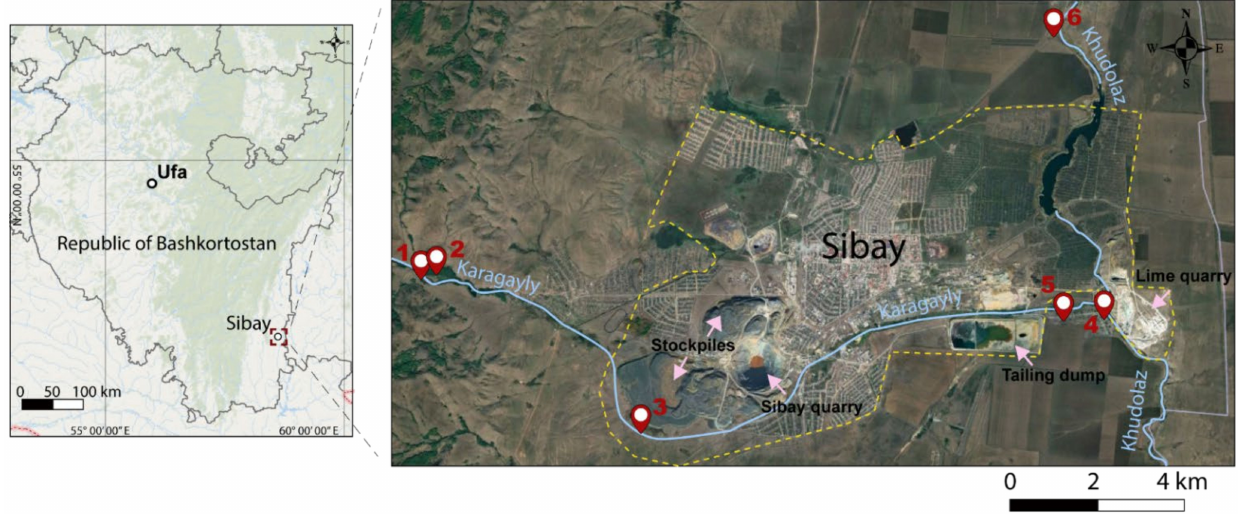
Figure 1. Maps showing the location of the Republic of Bashkortostan (Russia), Sibay city, Karagayly and Khudolaz rivers, and sample points location.